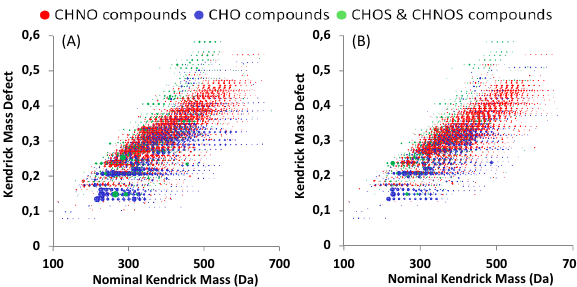
Fig. 2. The Kendrick mass defect vs. nominal Kendrick mass for the monoisotopic molecular formulas identified in CW1 (a) and CW2 (b) , with scaled symbol sizes representing the relative abundance of the